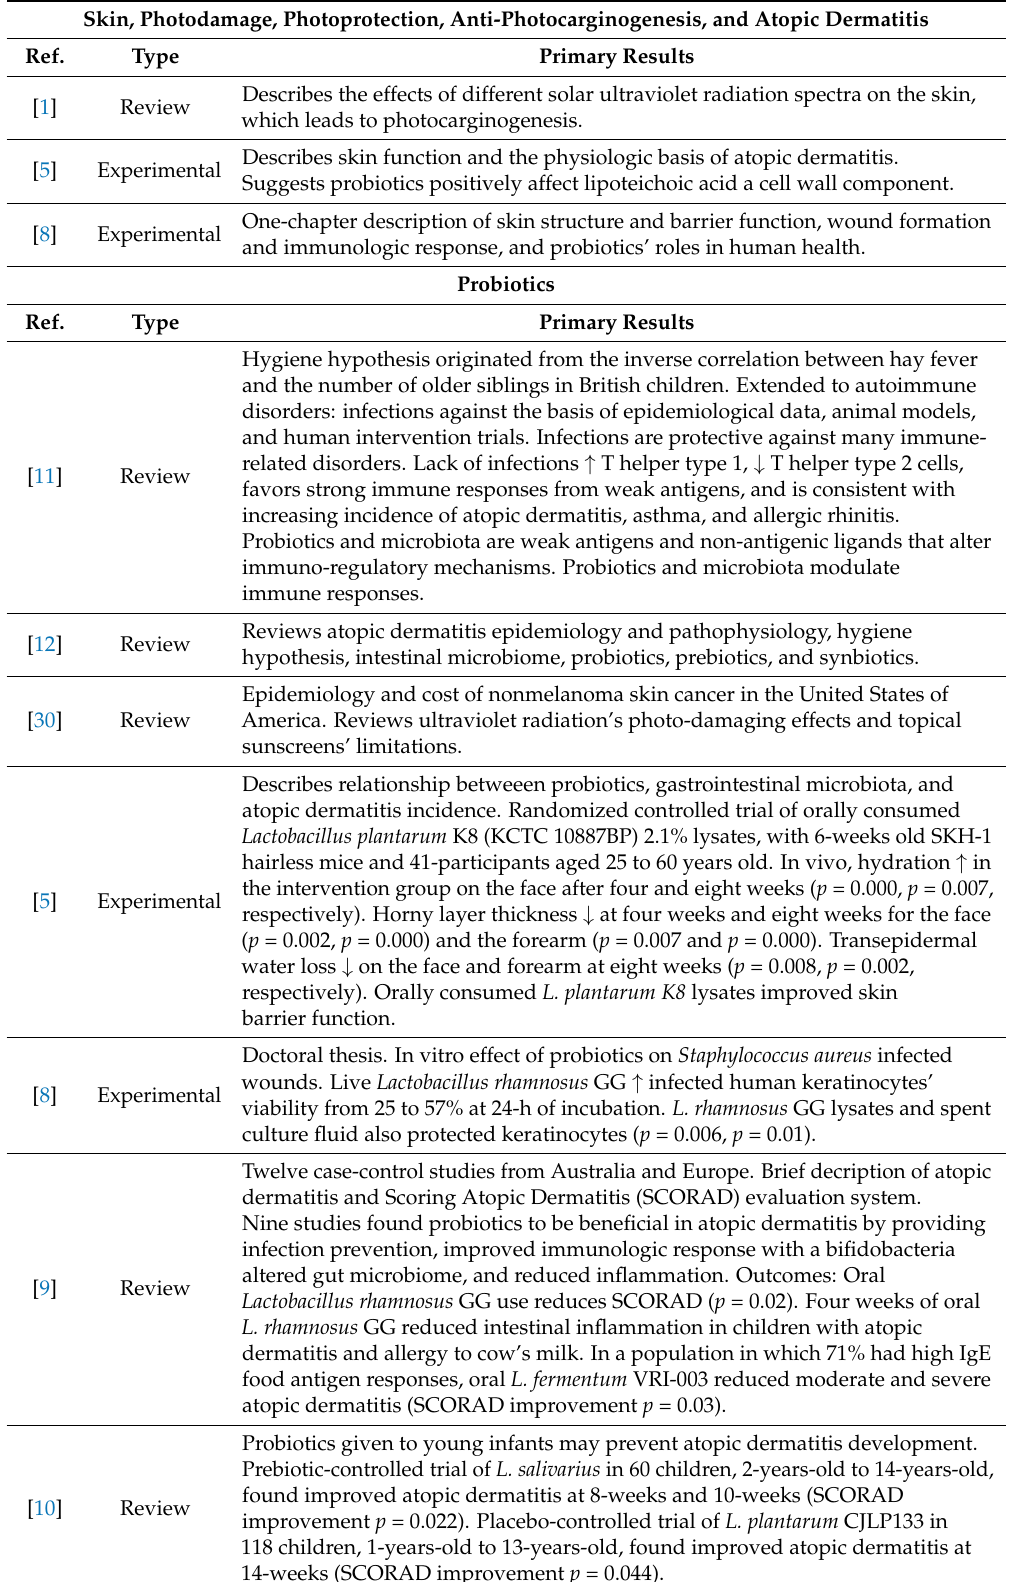
Table 1. Selected reference